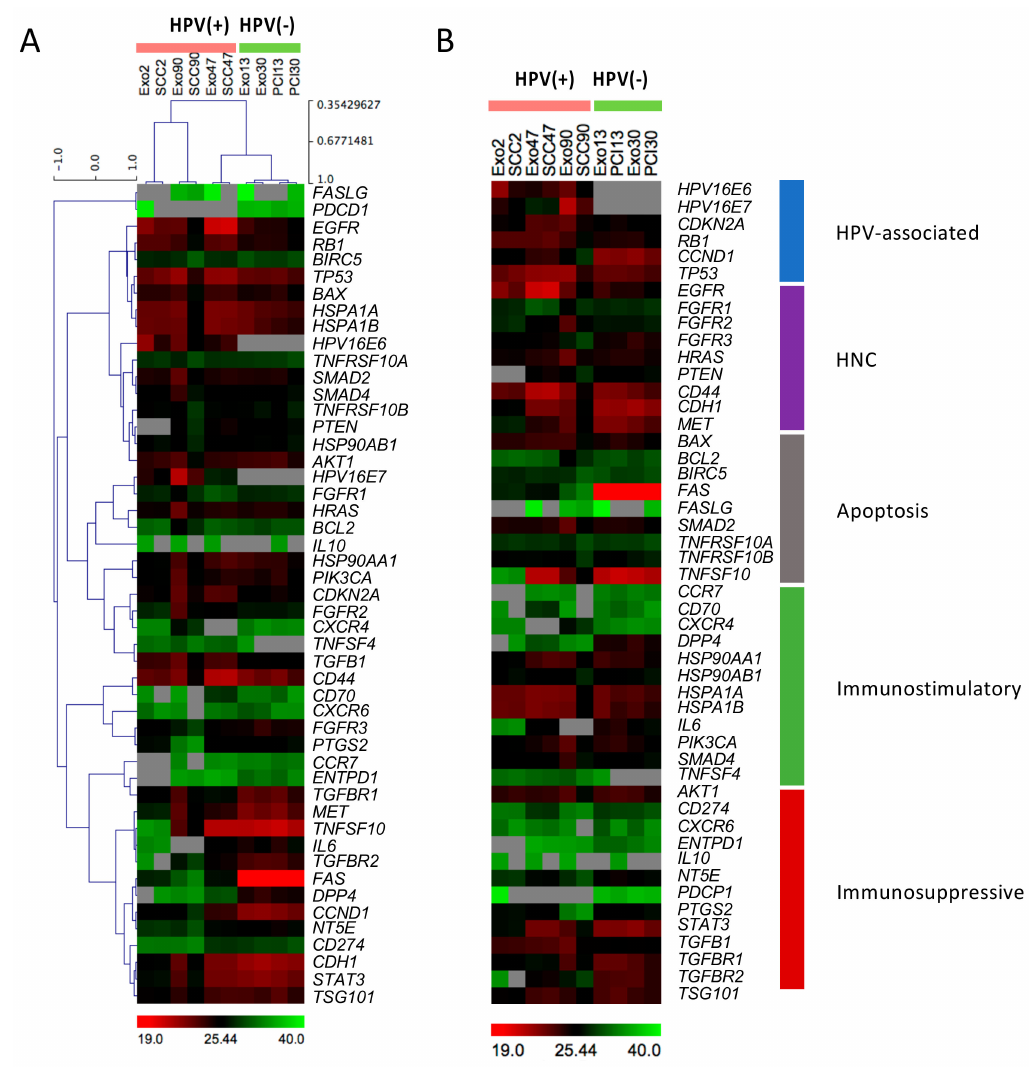
Figure 1. Absolute mRNA expression of HPV( + ) / ( − ) cell lines and exosomes. mRNAs were extracted from HPV( + ) and HPV( − ) cell lines and corresponding exosomes isolated by size exclusion chromatography. 1 ng mRNA from cell lines and exosomes was used to detect di ff erent mRNAs by PCR and compare their Ct values. All shown absolute Ct values / 1ng mRNA are means of triplicates. The heatmaps illustrate unsupervised ( A ) and supervised analysis ( B ) of the di ff erent mRNAs. Unsupervised analysis was performed using hierarchical and complete linkage clustering (Pearson correlation) to evaluate significant di ff erences. The supervised analysis compared mRNAs for their discriminating ability in terms of the origin (HPV or head and neck cancer (HNC)) or their immunological function (apoptosis, immunostimulatory or suppressive). The color codes range from low (green, Ct value 40), through medium (black, Ct value 25.44) to high expression levels (red, Ct value 19), and not detectable